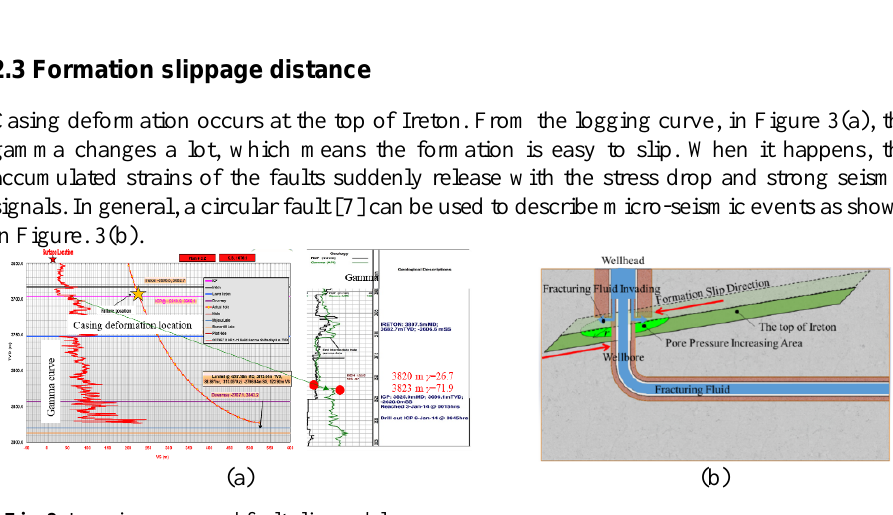
Fig. 2. Seismic signals during hydraulic fracturing:(a)Fracturing fluid volume,(b)relationship between the injection fluid and seismic response.